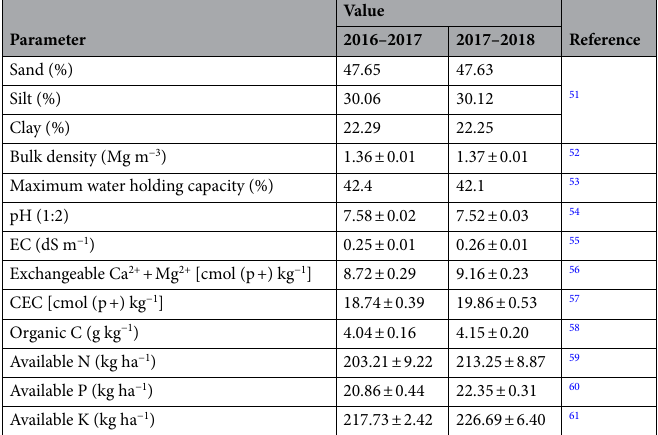
experiments. The initial analysis revealed that the soil was sandy loam in texture, slightly alkaline in reaction, low in organic carbon and available N content, and medium in available P and available K content.